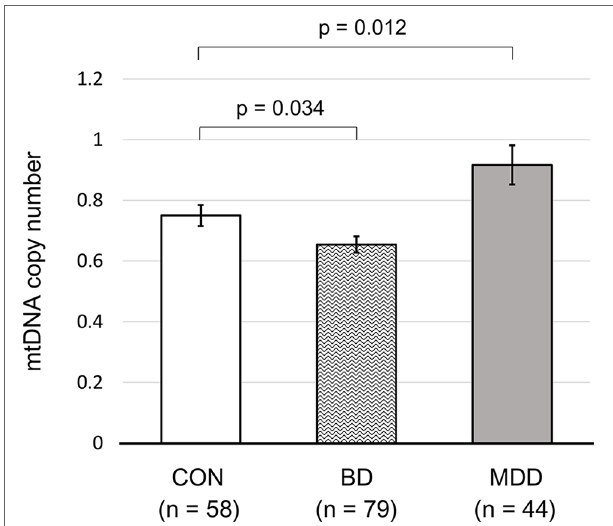
FIGURE 2 | The mtDNA copy numbers of control subjects and patients with bipolar or major depressive disorder. All P values were calculated using generalized linear models, considering patient age and sex. Error bars represent the standard error of the mean. CON, control; BD, bipolar disorder; MDD, major depressive disorder.